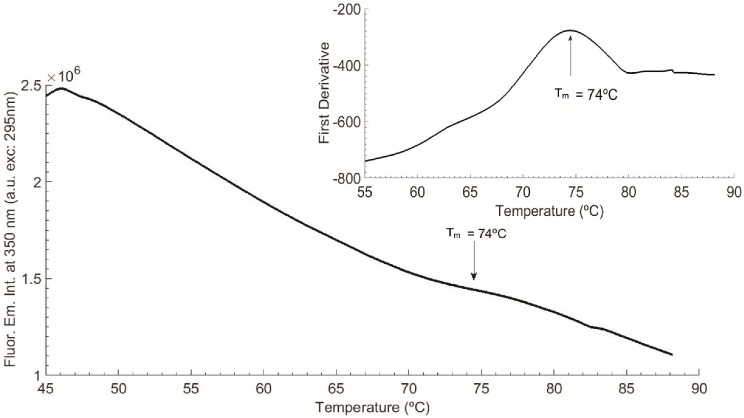
LYZ thermal ramp and data first derivative from 45–90°C (Tm = 74°C), with heating rate fixed at 1°C/min.Fluorescence excitation was fixed at 295 nm and fluorescence emission at 350 nm and excitation slit was set at 0.1 mm (0.1 μW).